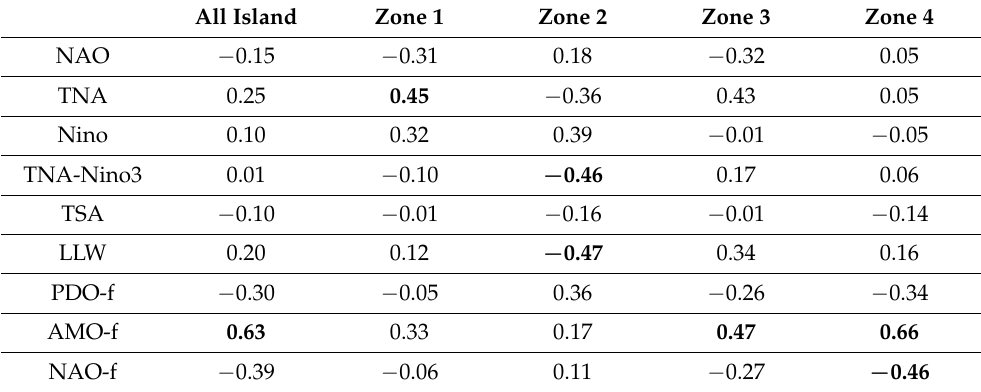
Table 7. Correlations between annual bushfire frequency and some annual climate indices calculated over 2001–2019 for concurrent periods. “ − f” are the low pass filtered components. Calculations with LLW and PDO are up to 2018 and 2017, respectively. Values in bold are significant at the 95% level. All